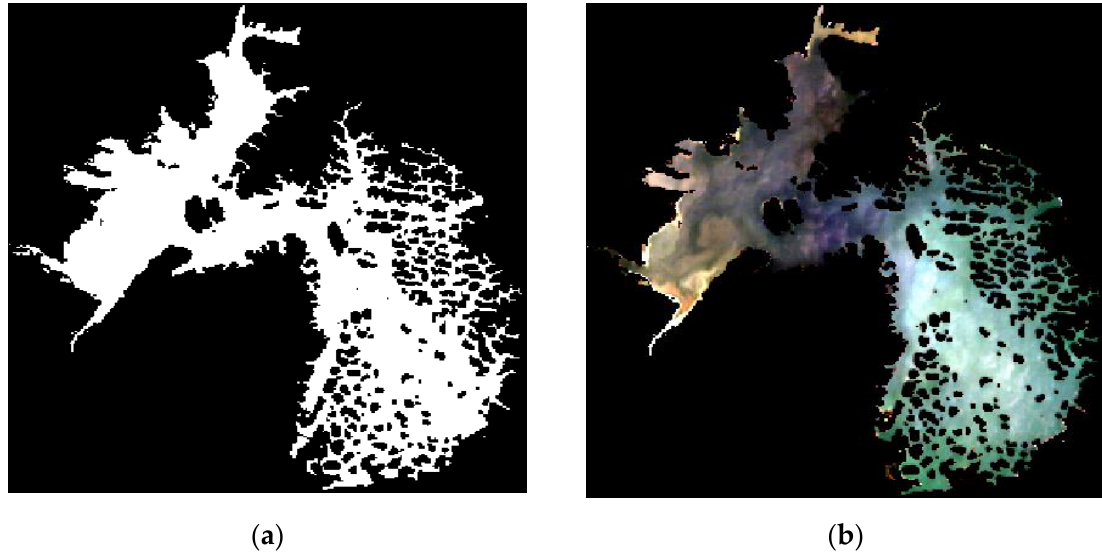
Figure 3. Water extraction by the NDWI method: ( a ) water mask and ( b ) after water extraction.